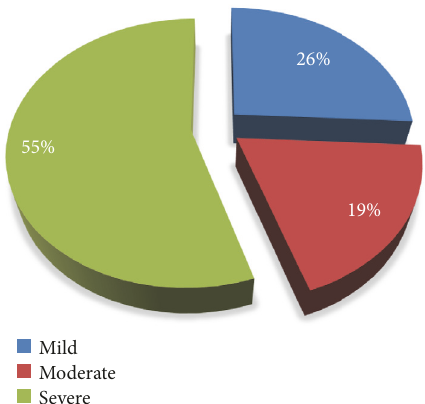
Figure 1: Distribution of severity of neuropathy assessment.